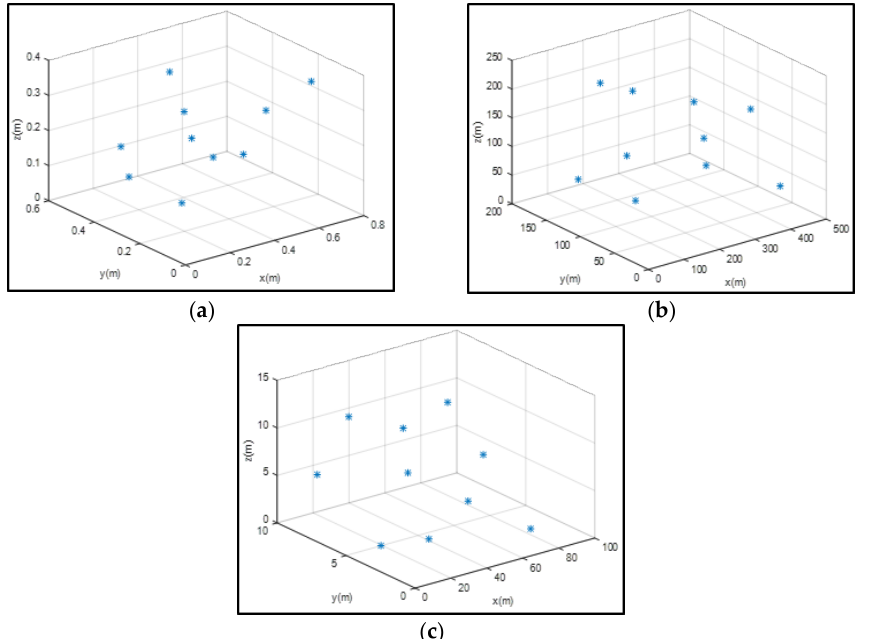
Figure 1. ( a ) First dataset concerning the microcosm. ( b ) Second dataset concerning the macrocosm. ( c ) Third dataset concerning intermediate distances.